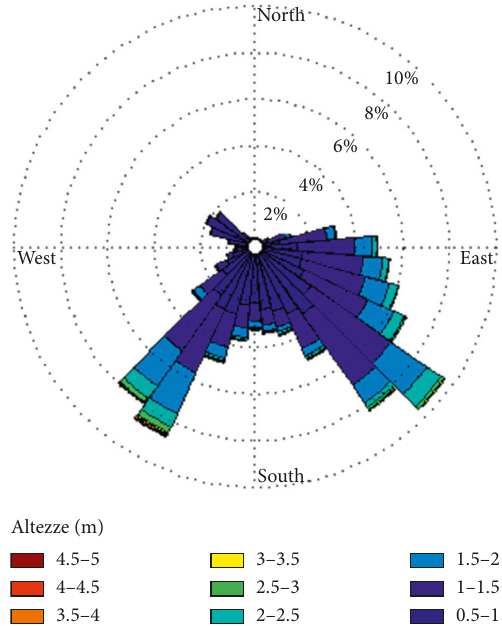
Figure 4: Rose chart of significant wave height at the Cagliari